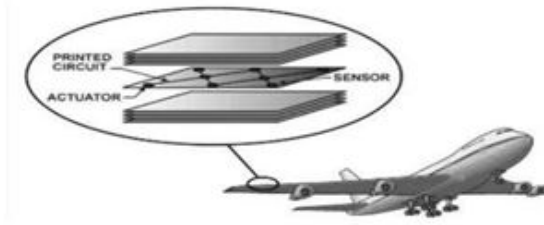
Figure 10. the insulating envelope of the aero planes (Akhras,2012)